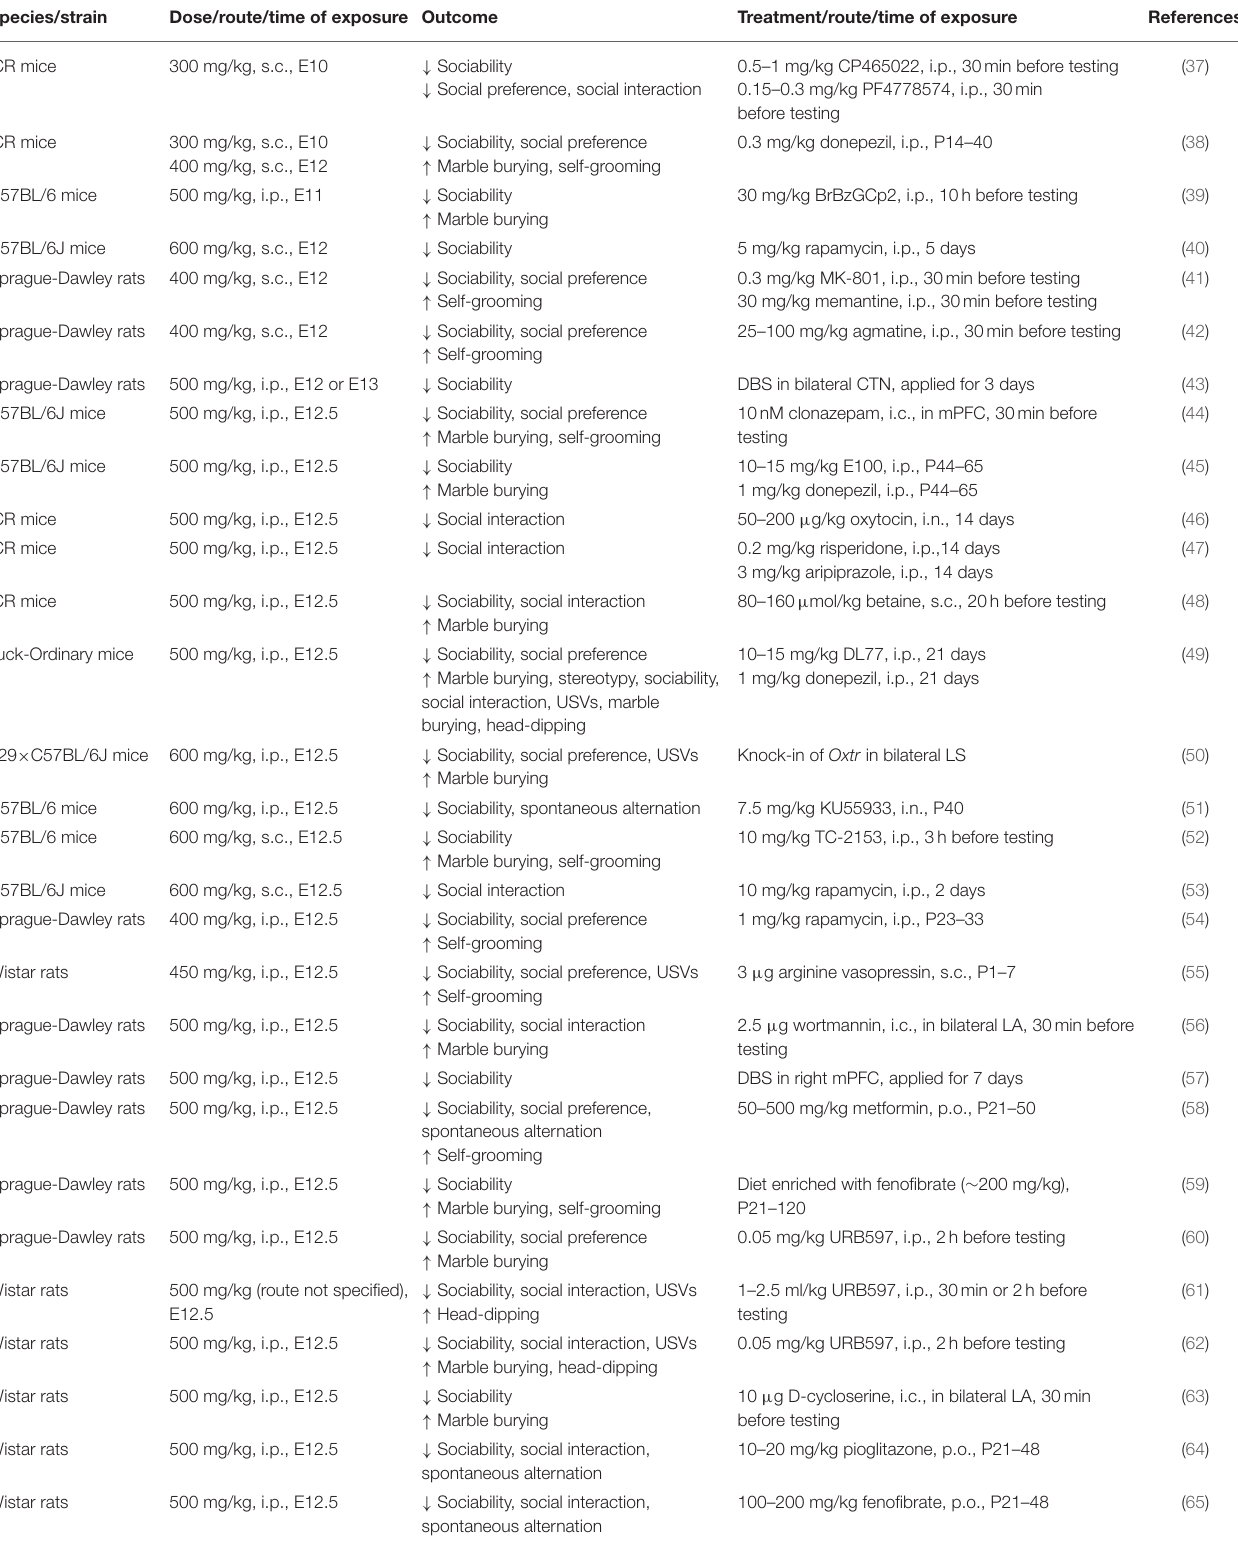
TABLE 1 | Postnatal treatment in ASD rodent models of prenatal exposure to